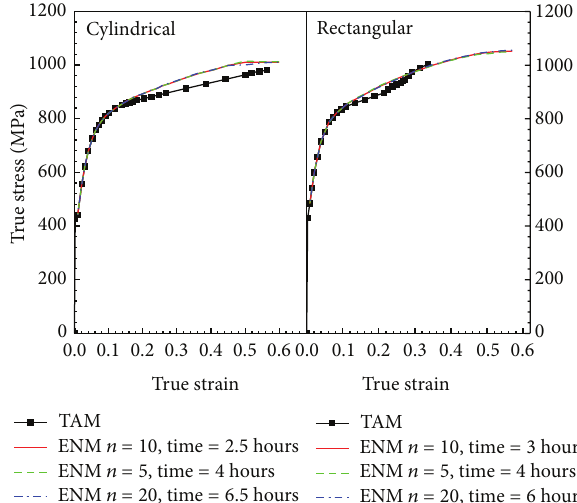
Figure5:Truestress-straincurvesdeterminedfromTAMandENM ( 𝑛 = 5 , 10, and